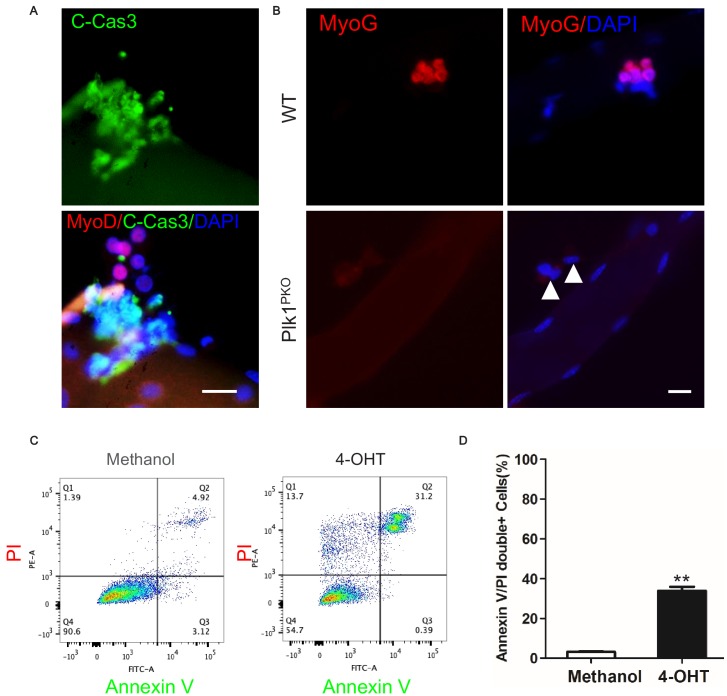
Deletion of Plk1-null MuSCs is due to apoptosis but not differentiation.(A) Representative images of MyoD (red) and cleaved Caspase-3 (green) staining in 72 hr cultured MuSCs of fresh isolated EDL single fibers treated with H2O2 for 30 min, scale bar: 10 μm; (B) Immunofluorescence of Myog (red) and DAPI (blue) in MuSCs on 3 day cultured EDL myofibers isolated from WT and Plk1PKO mice 7 days after TMX induction, white arrowheads point to undivided MuSCs on fibers from Plk1PKO mice, (C) Flow cytometry analysis of methanol or 4-OHT treated myoblast with Annexin V and PI staining to mark apoptotic cells; (D) Quantification of percentage of Annexin V/PI double positive myoblasts, data represent mean ± s.e.m. (t-test: **p<0.01; n = 4, biological replicates).